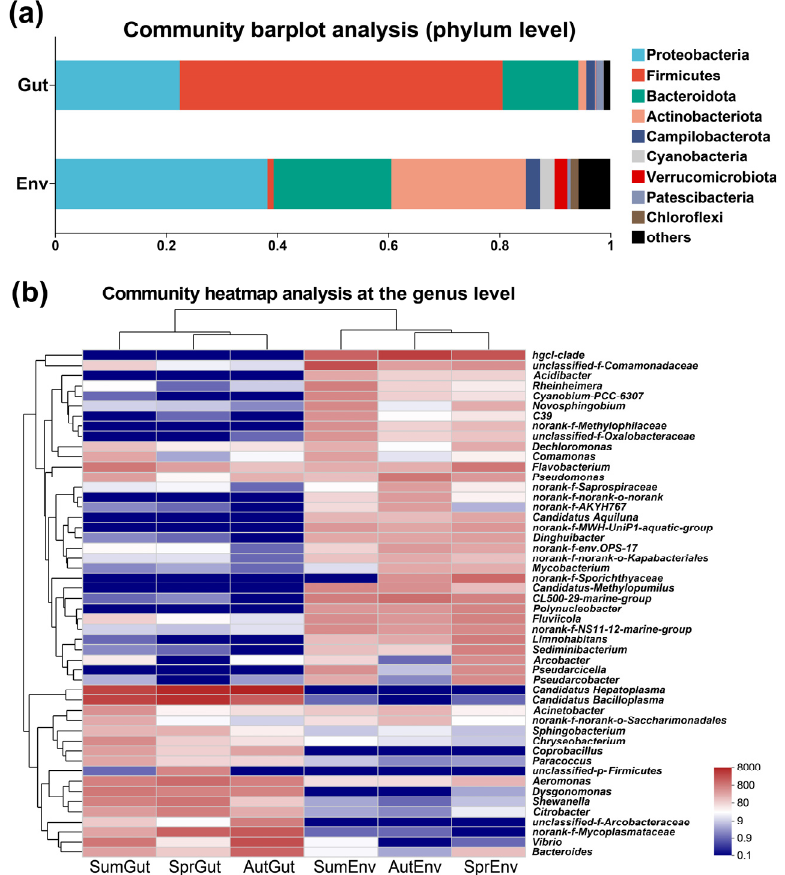
Figure 9. ( a ) Bacterial community composition at the phylum level of gut and water groups; ( b ) Heatmap of the relative abundance at the genus level among two groups.